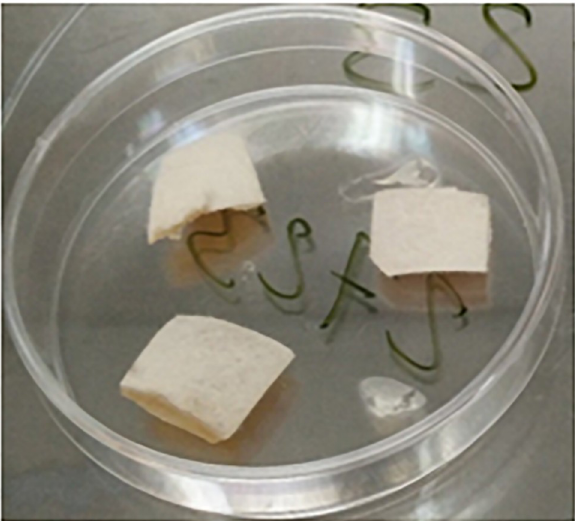
Fig 6. Porcine hoof samples (1 cm 2 ) inoculated with 10 5 CFUs of one of the fungal strains, after 2 weeks incubation period under water-saturated atmosphere. The white mycelium can be observed on the hoof